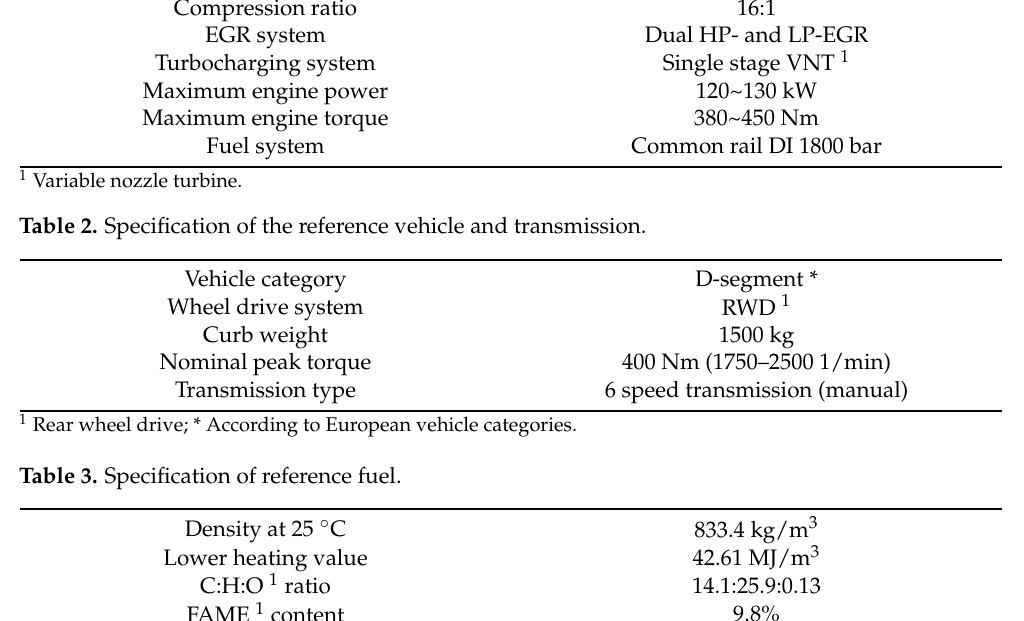
Table 1. Specification of the reference engine.